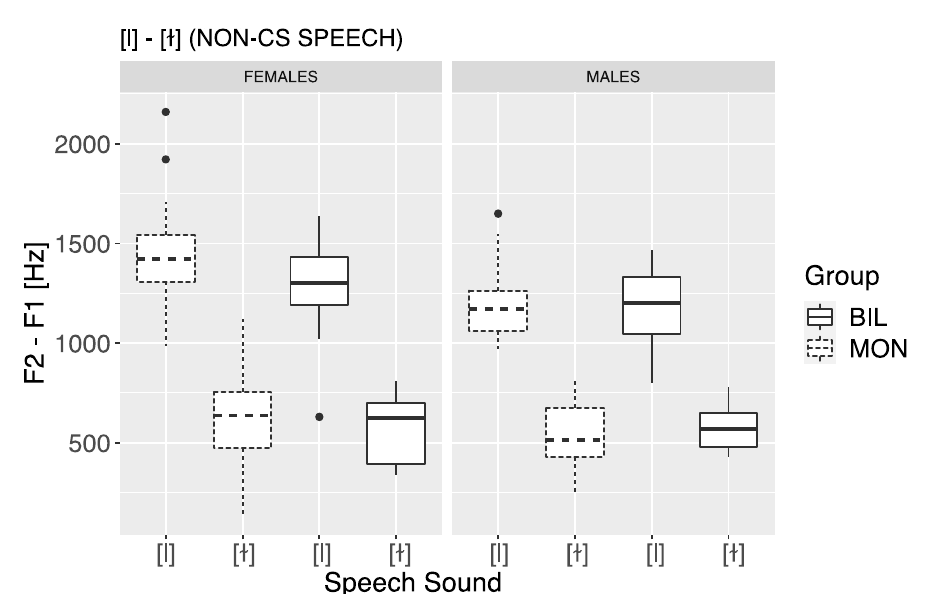
Figure 13. The distance between F1 and F2 of intended [l] and [ ł ] sounds in English words, spoken by the MON speakers (dashed), and by a selection of BIL speakers (solid) in non-CS environments who have been found to have shifted CS [ ł ] away from non-CS [ ł ]. The left panel shows female data, the right panel male